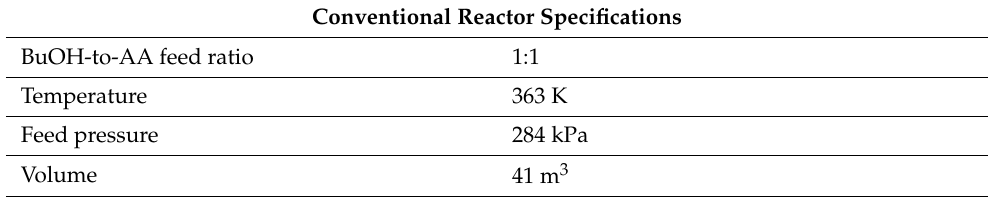
Table 6. Reactor design specifications for the conventional process.